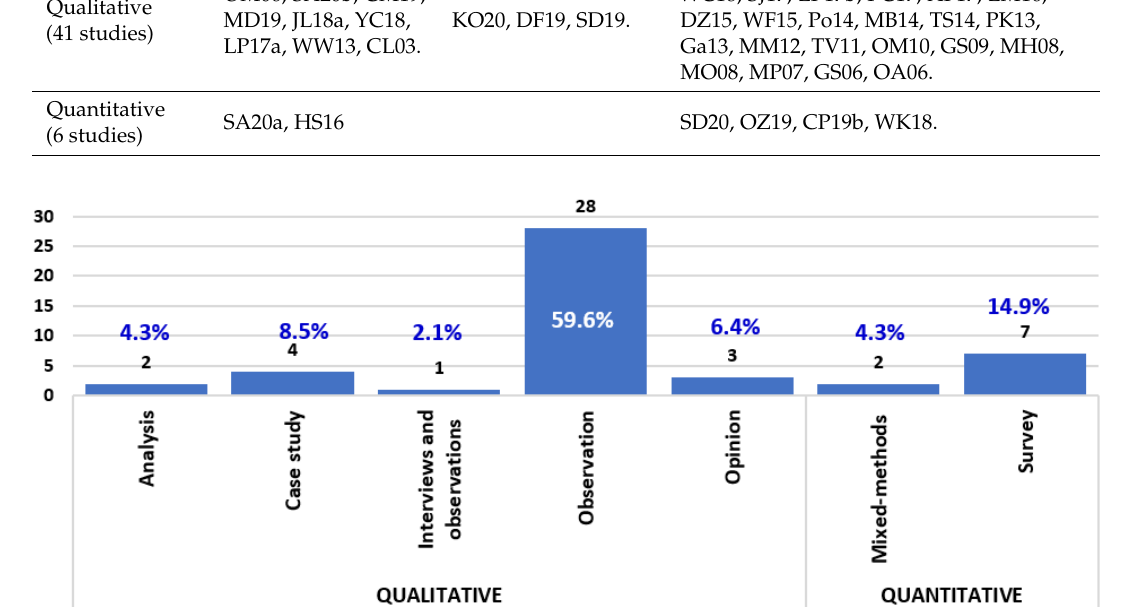
Figure 6. Methods and techniques applied in the design of serious games.